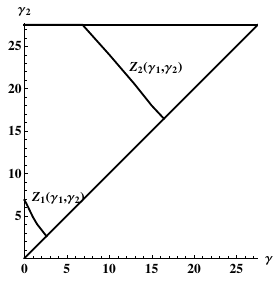
Figure 3. Z 1 (1), Z 2 (1) for BVP x (cid:48)(cid:48) = − 2 x 3 , x (0) = x (1) = 0 , u (cid:48) (0) = 0 , v (cid:48) (0) = 27 . 514 (precisely, since solutions are known analytically).